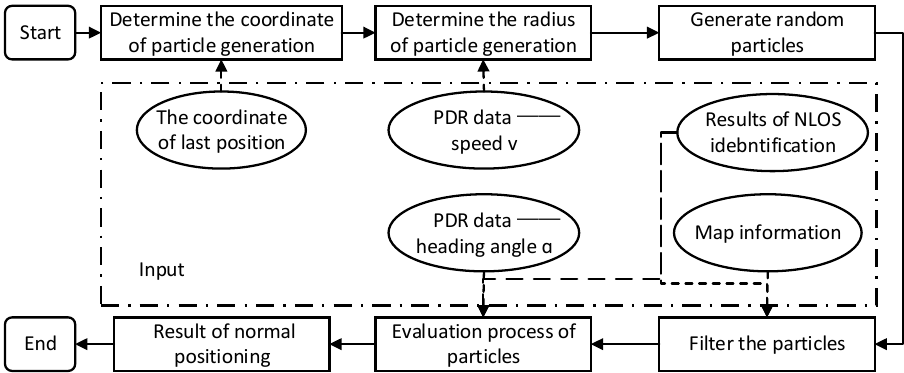
Figure 4. The procedure of the probabilistic position selection algorithm (PPSA).